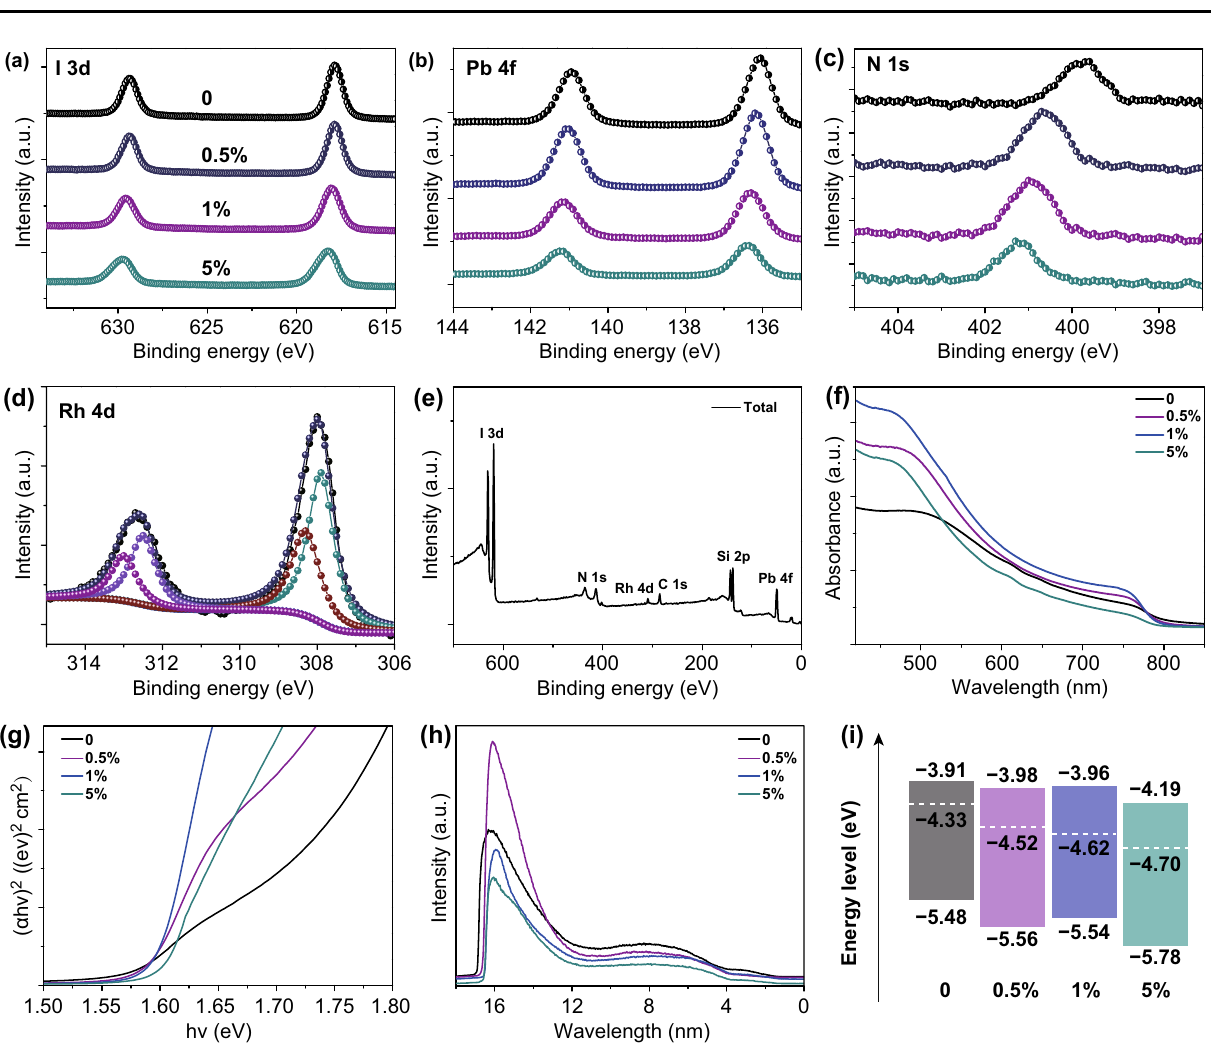
Fig. 3 XPS of a I 3 d , b Pb 4 f , c N 1 s from MAPbI 3 : x Rh (where x = 0, 0.5%, 1% and 5%). d Rh 4 d from MAPbI 3 : x Rh (where x = 1%). e XPS of total elements from the MAPbI 3 : x Rh (where x = 1%). f Absorbance coefficient of MAPbI 3 : x Rh. g Estimated bandgap potential of perovskite films. h UPS of MAPbI 3 : x Rh (where x = 0, 0.5%, 1% and 5%). i Energy level diagram of MAPbI 3 : x Rh (where x = 0, 0.5%, 1% and